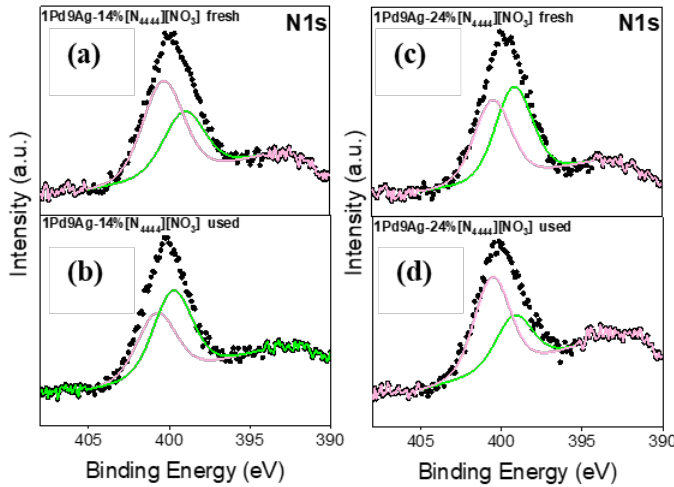
Figure 11. N 1s XP spectra for the fresh and used catalysts: fresh 1Pd9Ag-14%[N 4444 ][NO 3 ] ( a ), used 1Pd9Ag-14%[N 4444 ][NO 3 ] ( b ), fresh 1Pd9Ag-24%[N 4444 ][NO 3 ] ( c ) and used 1Pd9Ag-24%[N 4444 ][NO 3 ] ( d ). Solid black curves represent the raw data. Fitted individual components are also shown by solid-coloured curves.